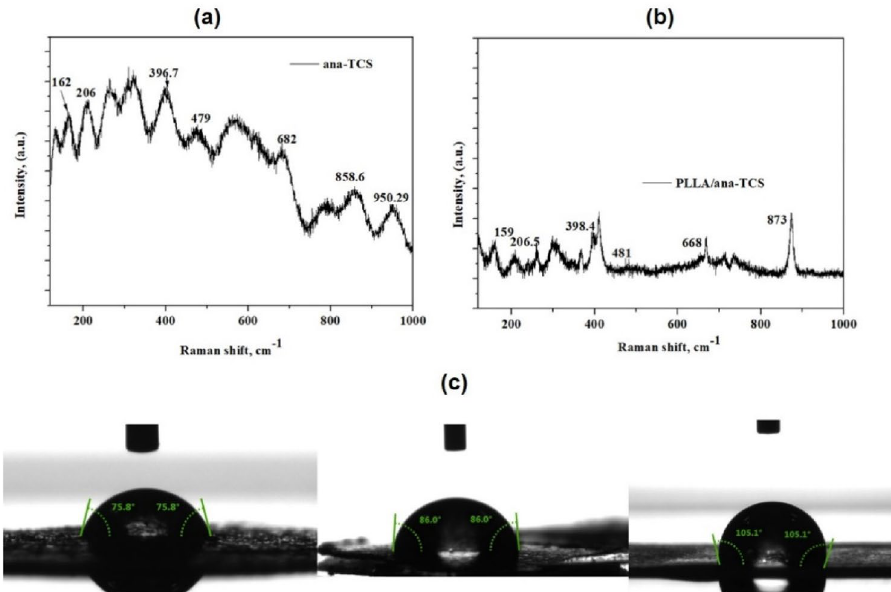
Figure 4. ( a ) Raman spectra of ana-TCS, ( b ) Raman spectra of PLLA/ana-TCS, ( c ) WCA meaasurement of ana-TCS, SNC and PLLA/ana-TCS (from